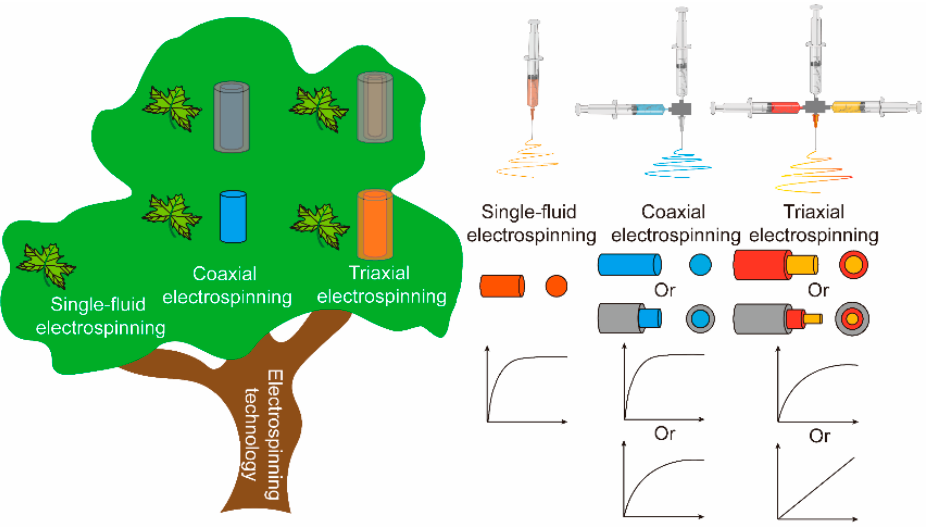
Figure 1. Schematic of electrospinning technology and its resulting fibers with different drug release performances.